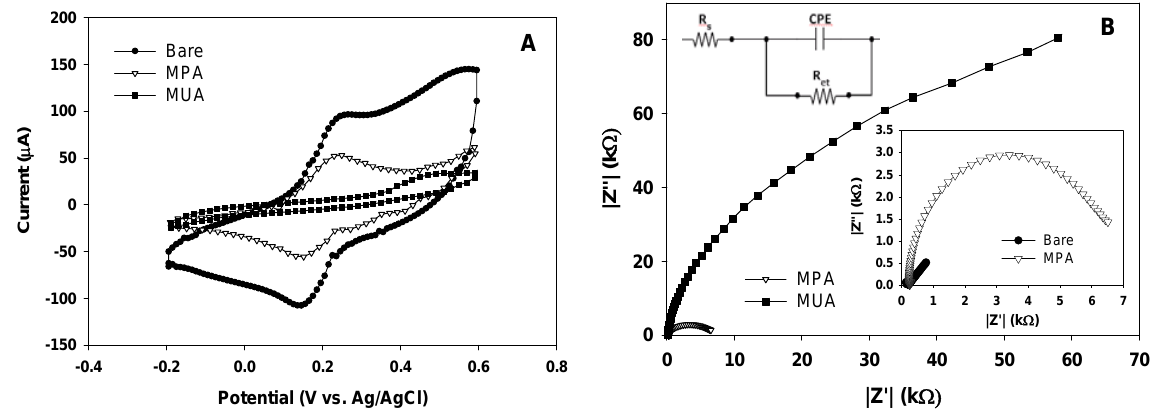
Figure. 2. (A) CV curves obtained for a bare, a MPA and a MUA treated electrodes evaluated with Fe(CN) 63-/4- as the redox couple. (B) The corresponding Nyquist plots from the impedance measurements for the same electrodes with a close-up view of the low impedance range given in the lower inset. A Randles equivalent circuit consisting of a solution resistance (Rs), an electron-transfer resistance (Ret) and a constant phase element (CPE) capacitor is given in the upper